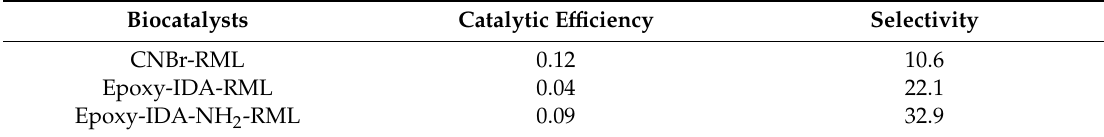
Table 3. Fish oil hydrolysis by using the selected biocatalysts at pH 5, 4 ◦ C.